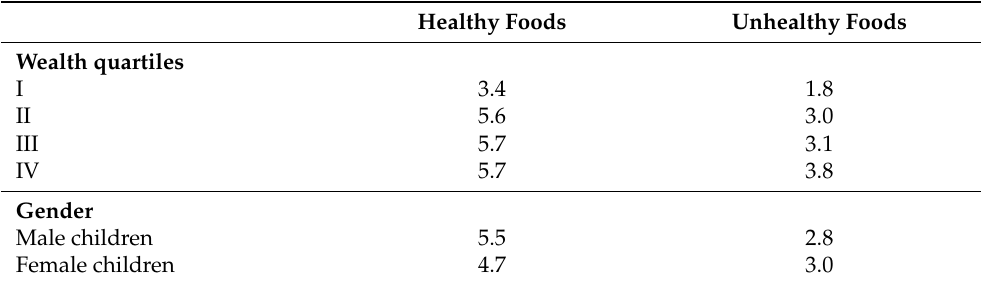
Table 7. Average number of healthy and unhealthy food groups consumed in the 2 days prior to the survey by children in Oyo State across different wealth quartiles and gender [13]. Healthy